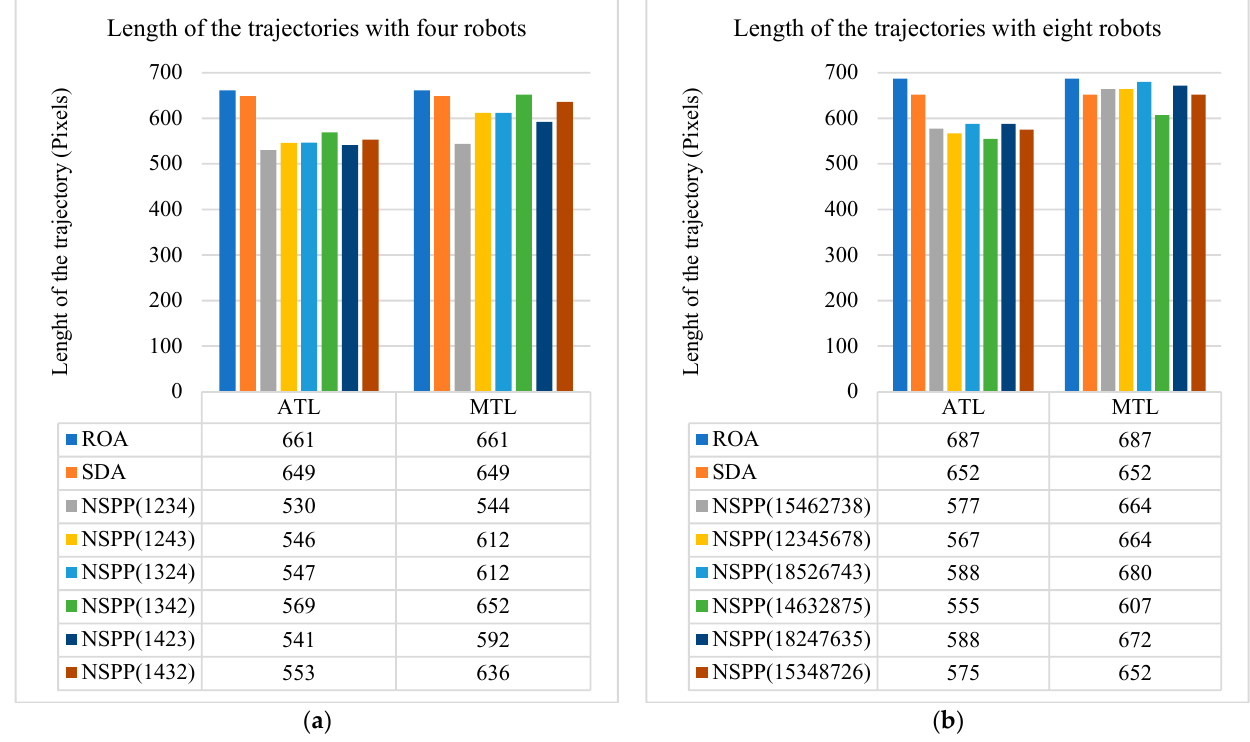
Figure 16. ( a ) Trajectory length comparison of ROA, SDA, and NSPP for four robots; ( b ) trajectory length comparison of ROA, SDA, and NSPP for eight robots.